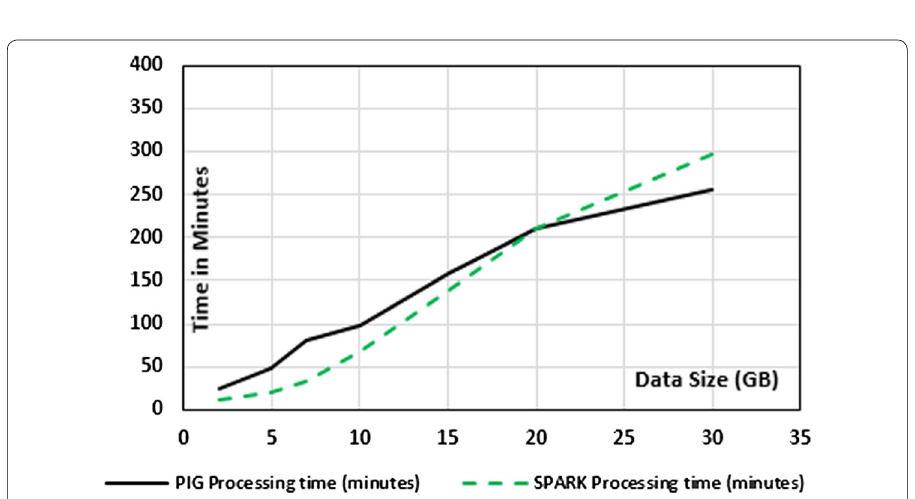
Fig. 7 Comparison in process‑time between Pig and Scala scripts with 6 workers: This is the second experiment where 6 workers and one master are used. The experiment showed a good performance for Spark, when data size is smaller than 20 GB. Pig gains better performance when data size increases dramatically in comparison with the available